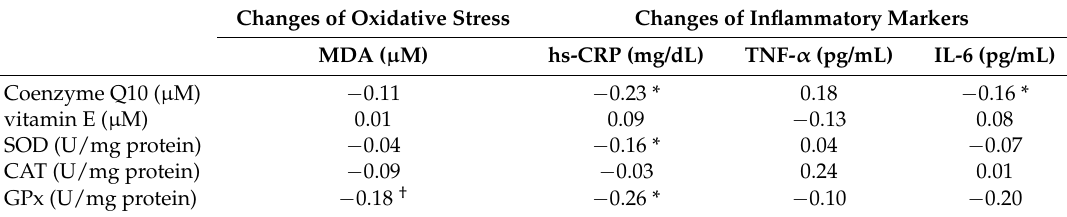
Table 4. Correlations 1 between changes in coenzyme Q10, oxidative stress, and inflammation. Changes of Oxidative Stress Changes of Inflammatory